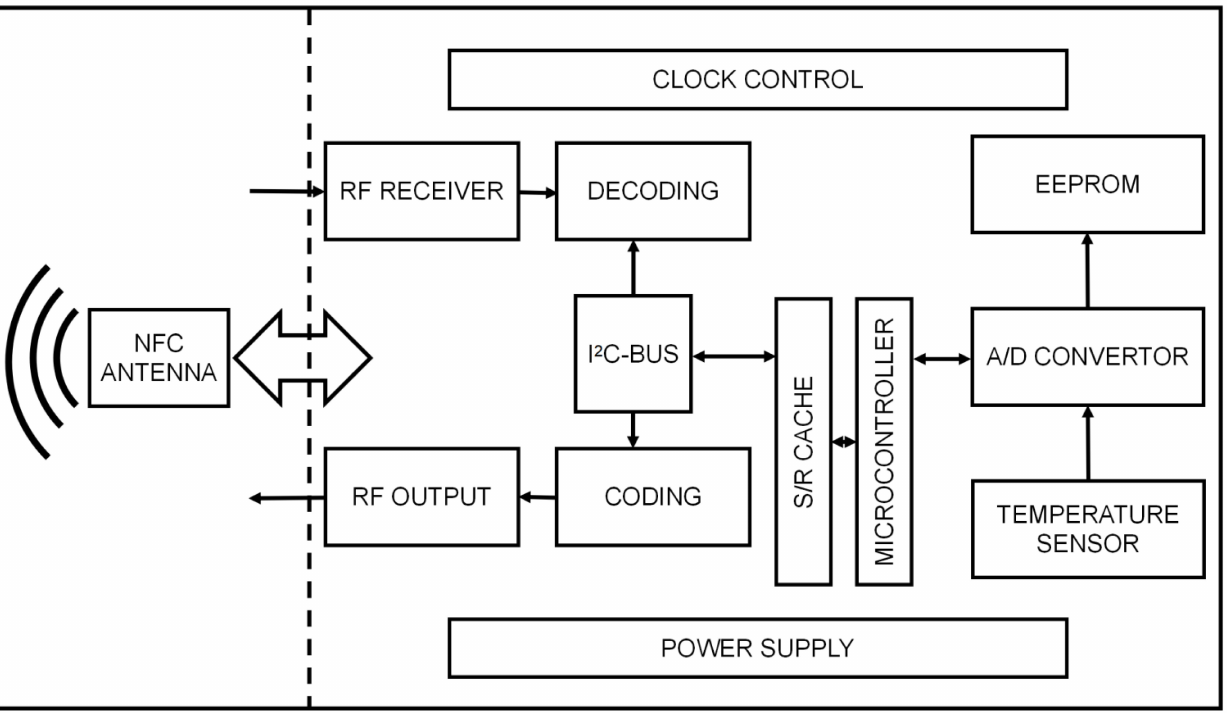
Figure 3. Schematic diagram of electronic configuration on graphene-enhanced PDMS patch for wearable body temperature monitoring. Note that the temperature sensor was integrated with the temperature patch enclosed by